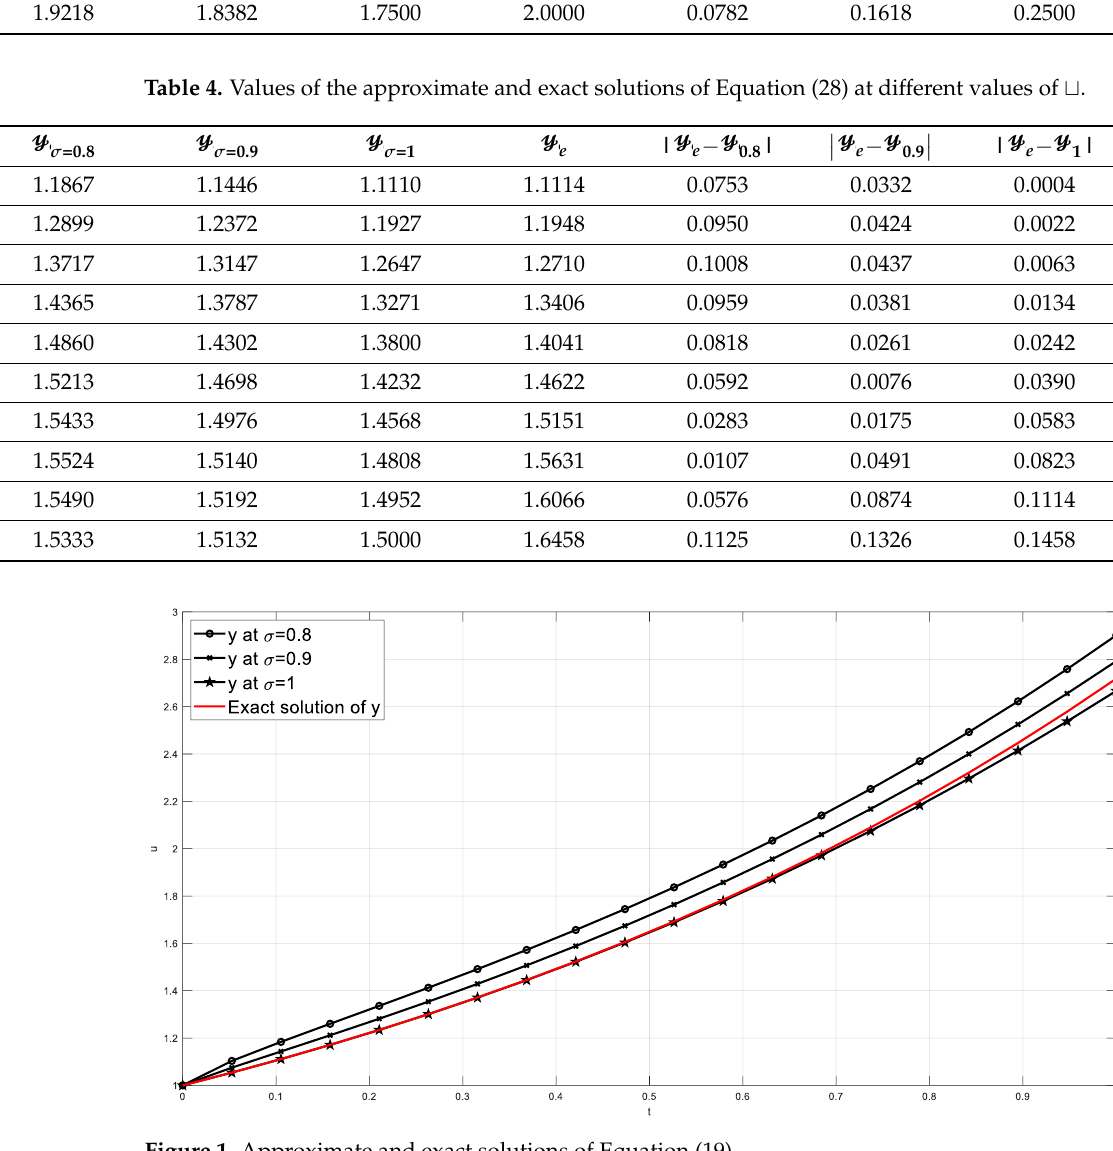
Figure 1. Approximate and exact solutions of Equation (19). Table 2. Values of the approximate and exact solutions of Equation (24) at different values of 𝓉 .